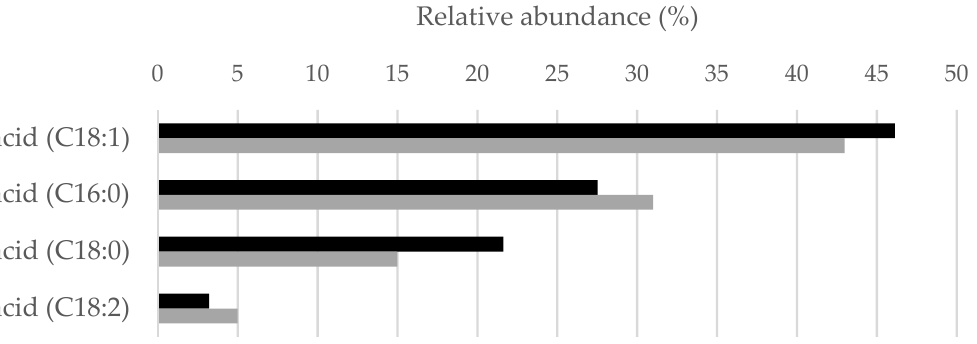
Figure 7. Comparison between the major fatty acids produced by C. oleaginosus ATCC 20509 on WPYEU (black bars) and on glucose [23] (gray bars).